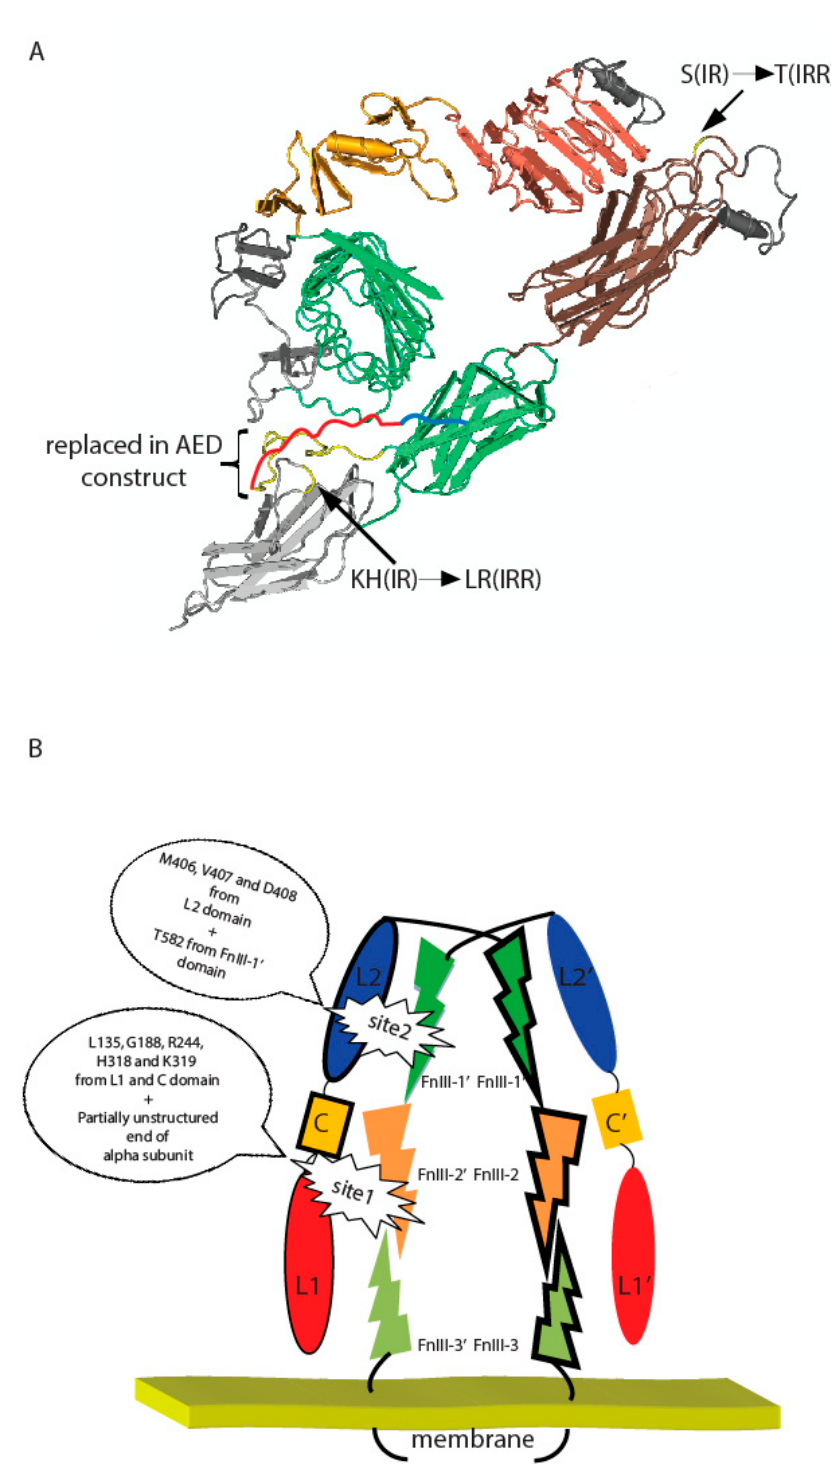
Figure 5. ( A ) Positions of indicated T582, L868, R869, and region (646–716) within fibronectin repeats domains and their IR substitutes on a putative three-dimensional model of IRR built according to the described structure of IR ectodomain [23] with Cn3D 4.3.1 software (NCBI, Bethesda, MD, USA). Region, which were swapped in AED chimera construct, was indicated by yellow color (presented in IR ectodomain structure) and red color (unstructured part of IR alpha subunit). Blue color showed rest of unstructured part of IR alpha subunit. ( B ) Two-site activation model of IRR. Important residues are indicated. Domains indicated by different colors. Monomers indicated by trait.